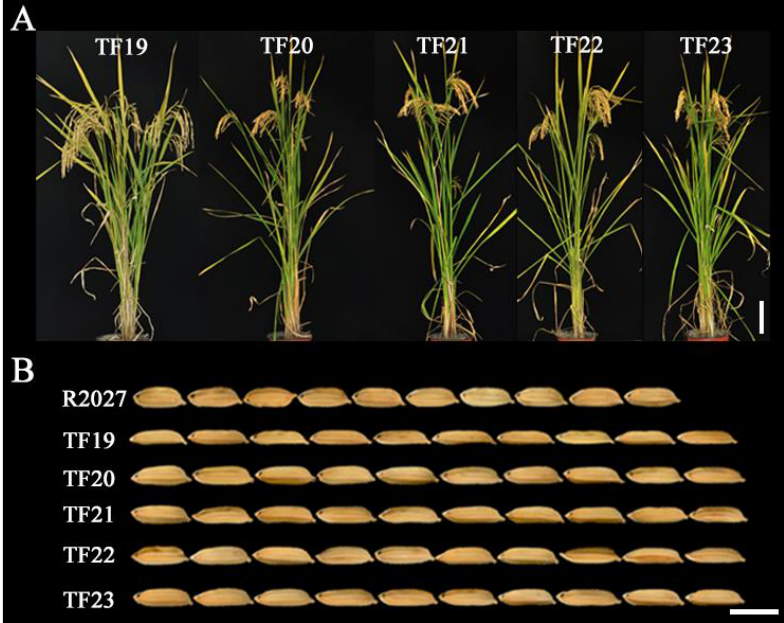
Figure 5. Phenotypes of five TF lineage plants. Scale bar = 10 cm for ( A ) and 1 cm for ( B ). Table 3. Comparison of the main agronomic traits between five TF lineage plants and two parents (mean ± SD, n = 10).